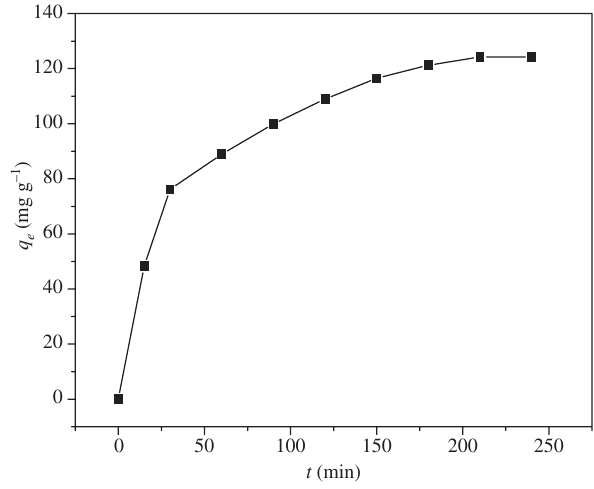
Figure 10: Effect of contact time on the adsorption of MB by O /C-CAA microspheres at pH 11 and 25 ° Fe 3 4